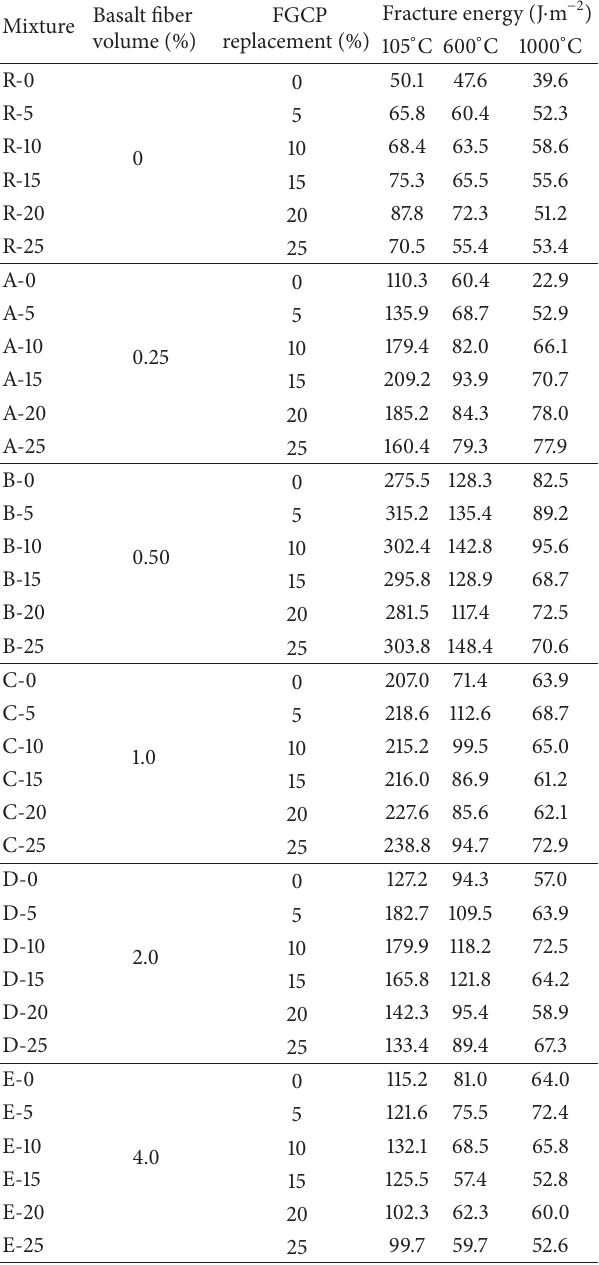
Table 4: Fracture energy of studied composites.